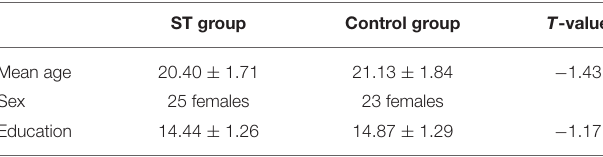
TABLE 1 | The demographic information of Stereotype threat (ST) and control